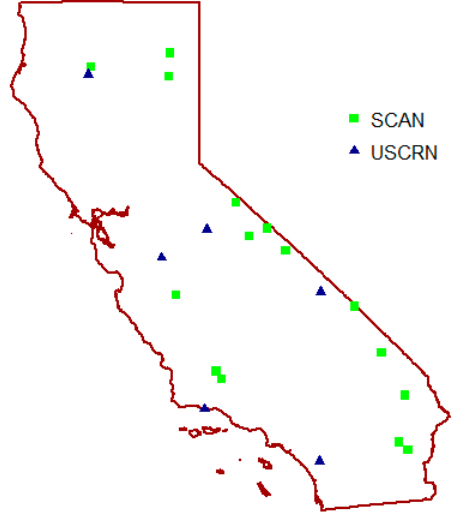
Figure 15. Spatial distribution of the SCAN and USCRN soil moisture stations over the study area used for the independent validation.